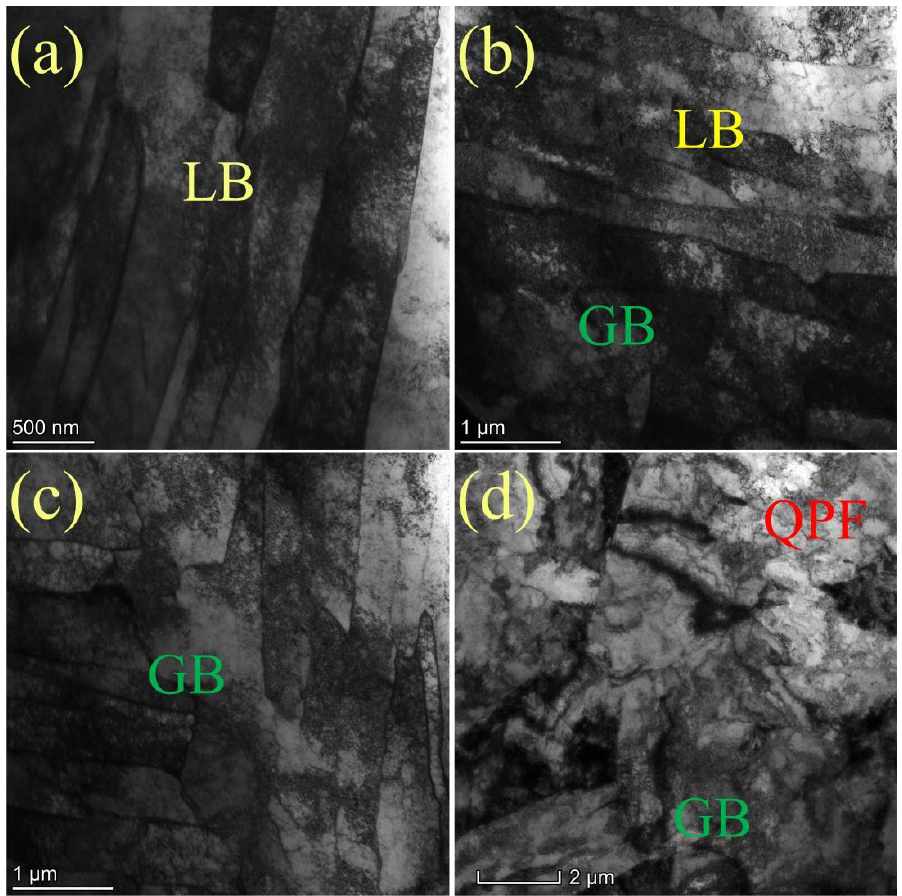
Figure 6. TEM micropraphs of heavy-wall seamless bend pipe steel after tempering at ( a ) 550 °C , ( b ) 600 °C , ( c ) 650 °C , and ( d ) 700 °C .